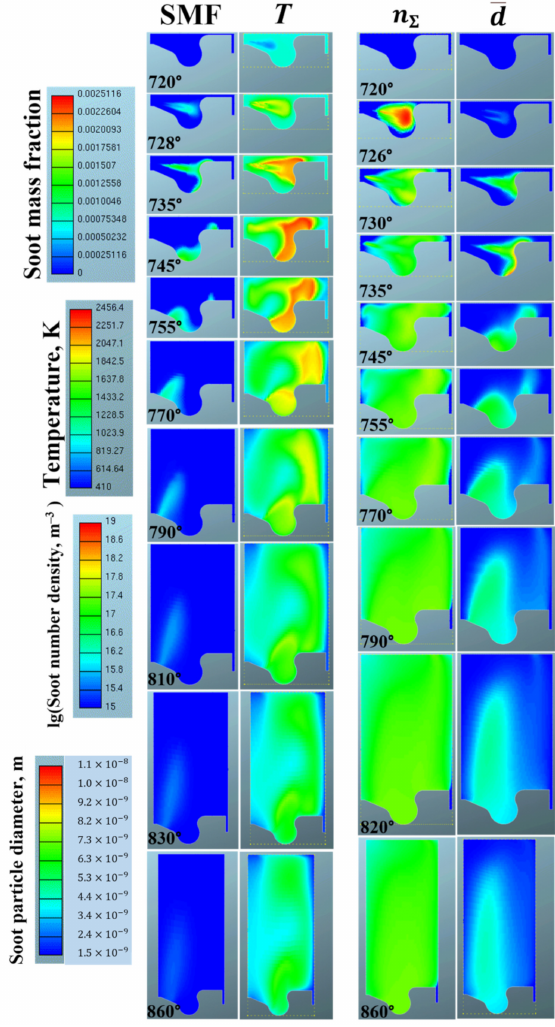
Figure 7. Snapshots of soot mass fraction, temperature, soot particle number density, and mean diameter at different crank